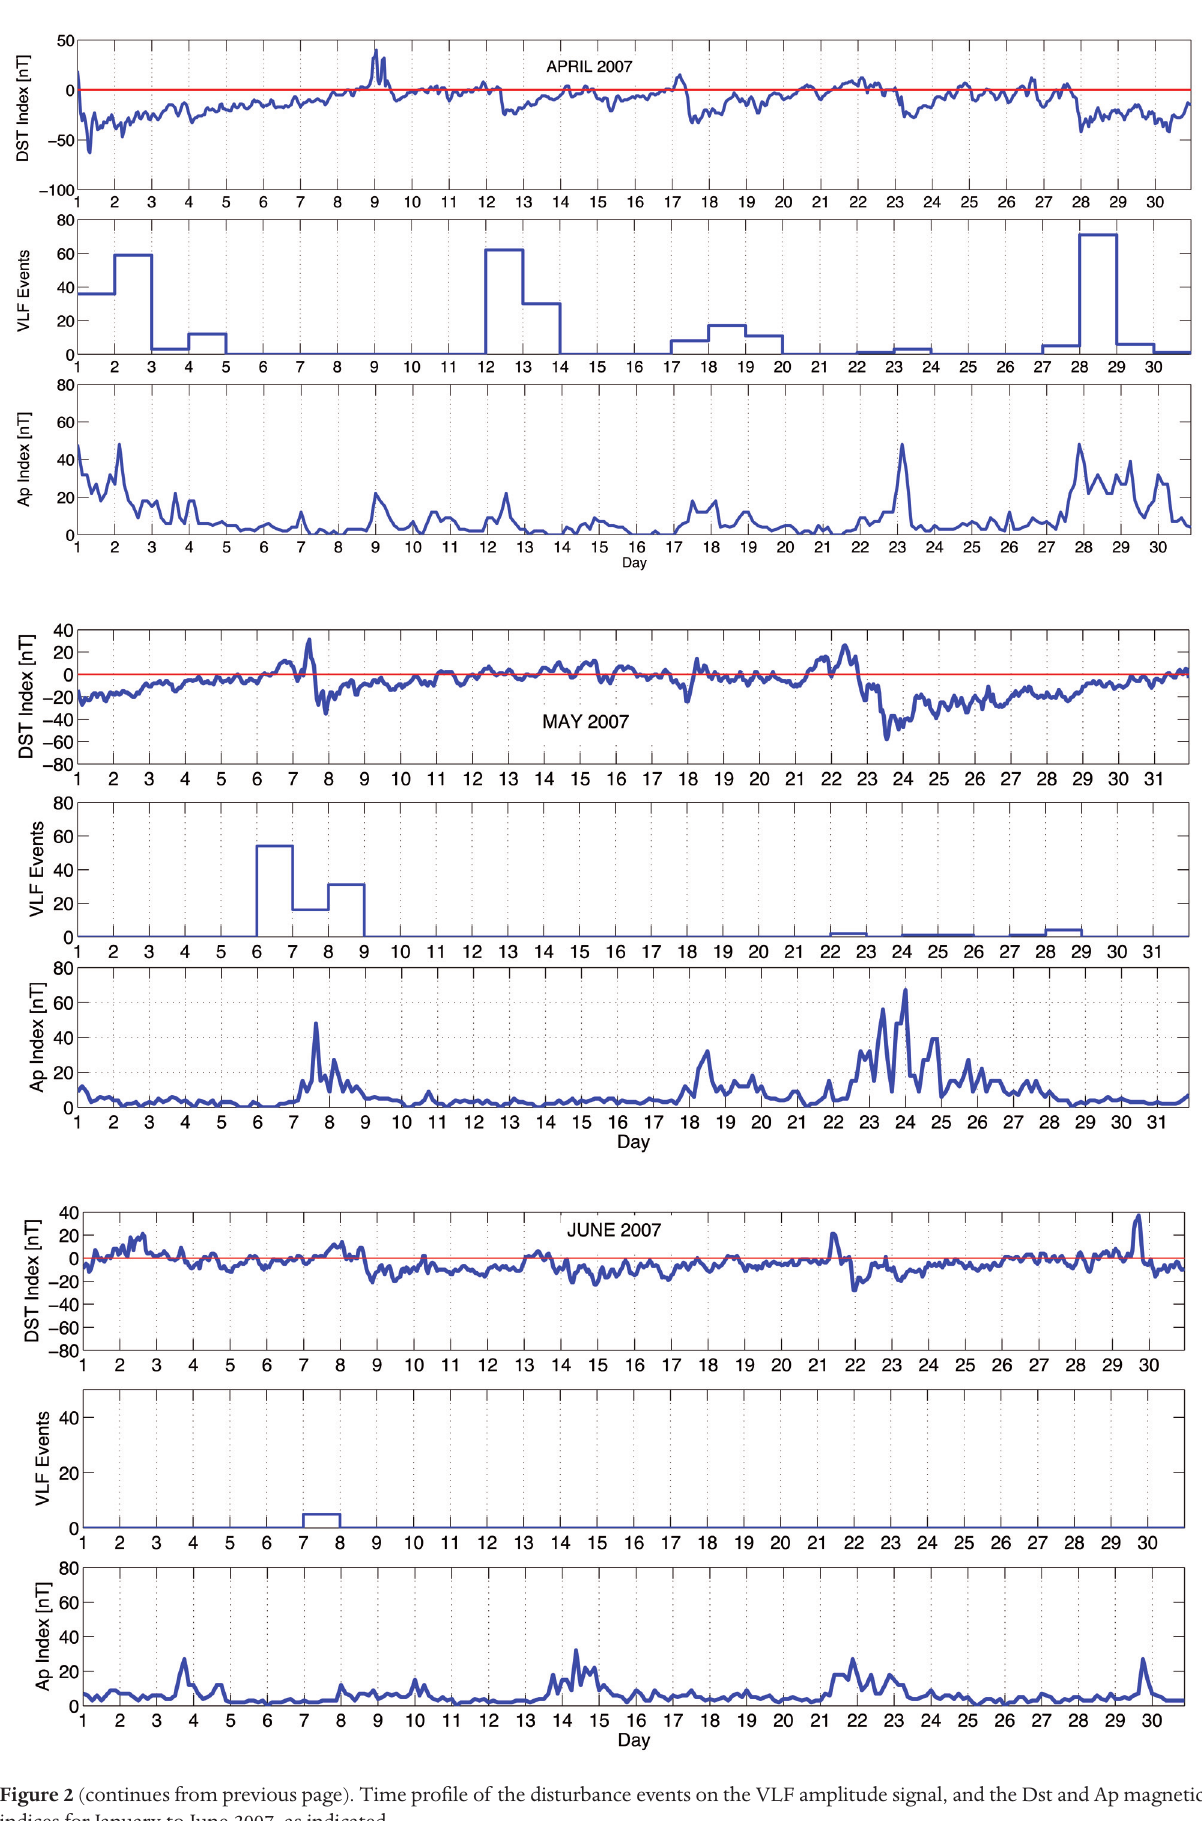
Figure 2 (continues from previous page). Time profile of the disturbance events on the VLF amplitude signal, and the Dst and Ap magnetic indices for January to June 2007, as